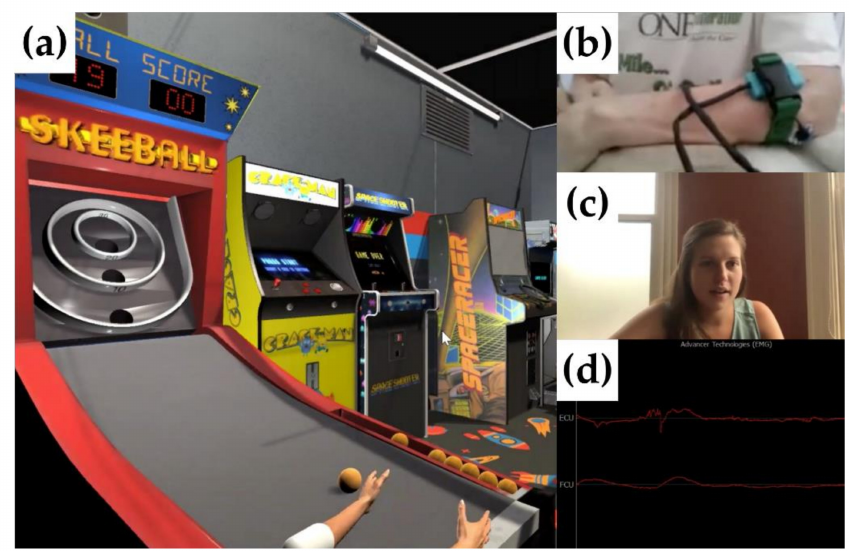
Figure 3. Feedback displayed during a session guided by an occupational therapist. ( a ) SkeeBall game rendered on the computer screen. ( b ) View from the laptop camera of the participant’s arm with electrode placements. ( c ) Occupational therapist guiding the session. ( d ) Real-time visualization of the EMG